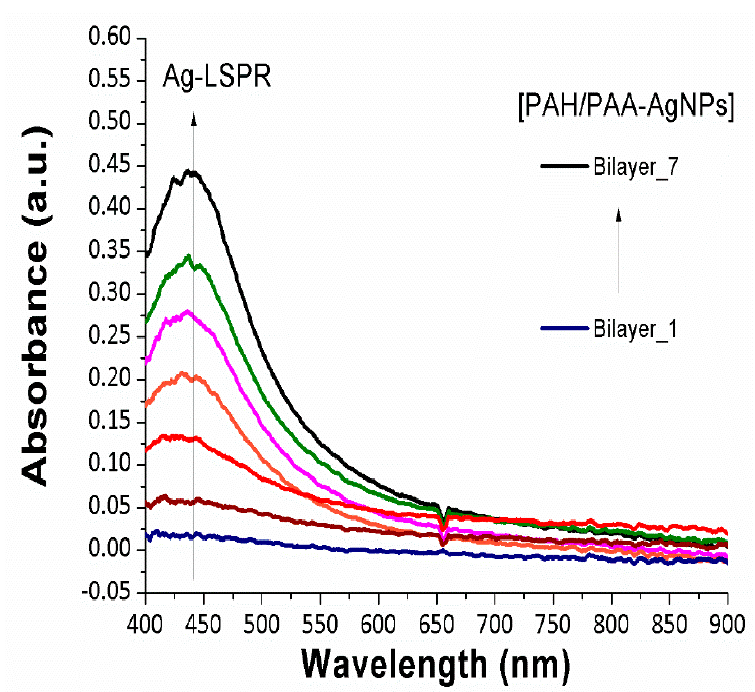
Figure 5. UV-Vis spectra during the fabrication of the Layer-by-Layer films based on the immobilization of metallic AgNPs. The curves are plotted from 1 up to 7 bilayers, respectively.